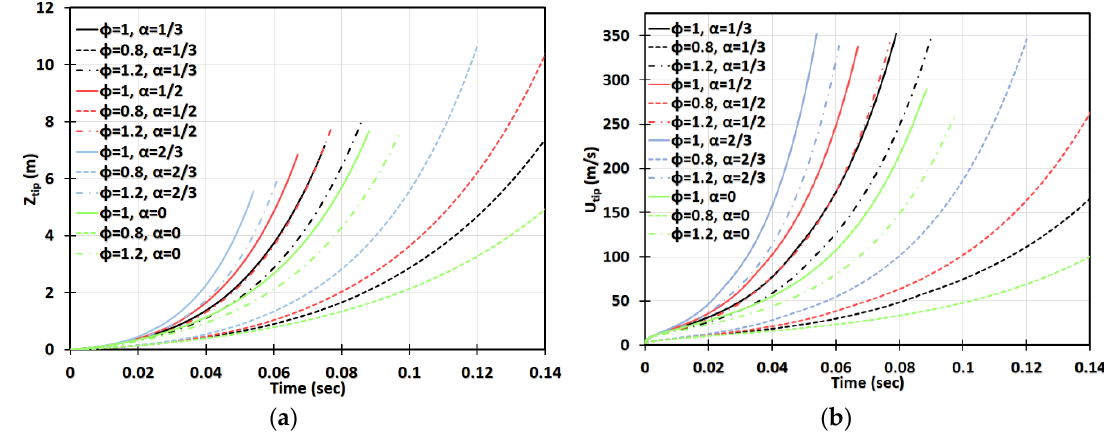
Figure 6. Time evolution of the flame tip position Z tip ( a ) and velocity U tip ( b ) in a 2D geometry for lean ( φ = 0.8), stoichiometric ( φ = 1), and rich ( φ = 1.2) CH 4 -air burning with various blockage ratios α = 0, 1 3,⁄ 1 2,⁄ 2 3⁄ .